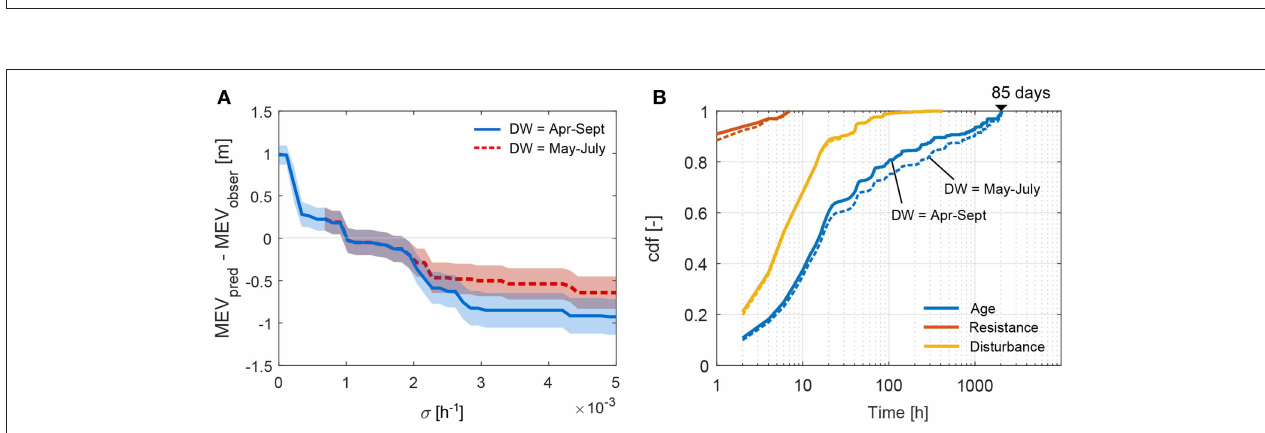
Frontiers in Environmental Science |